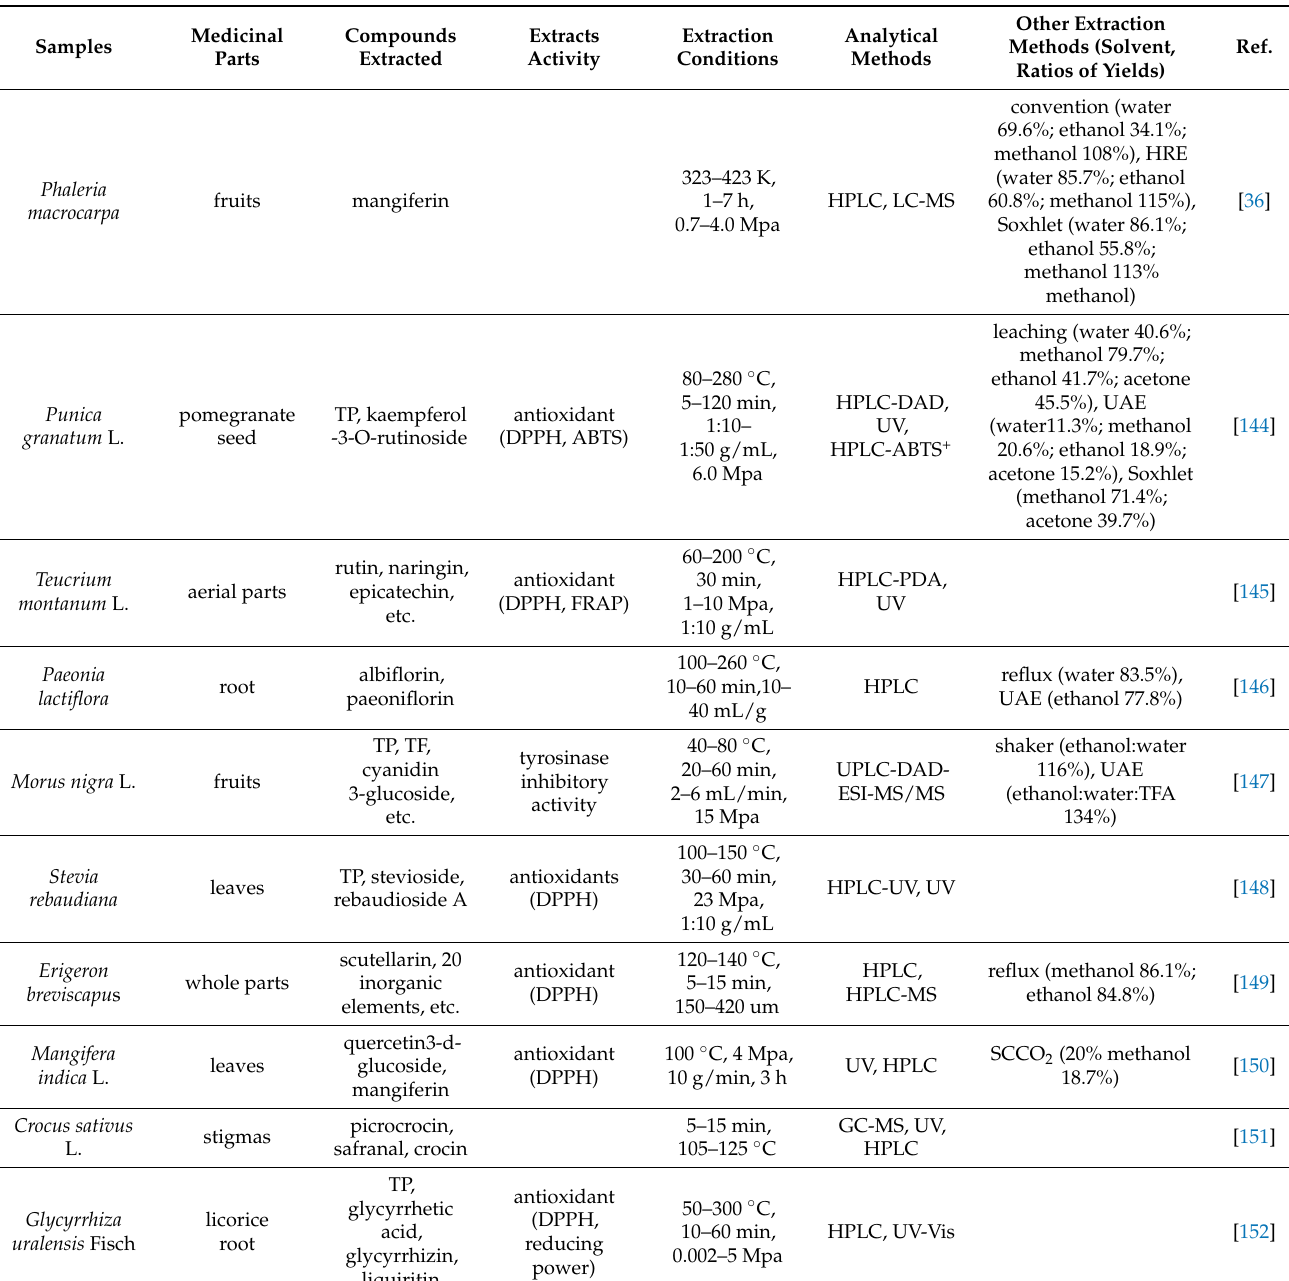
Table 4. Subcritical water extraction of